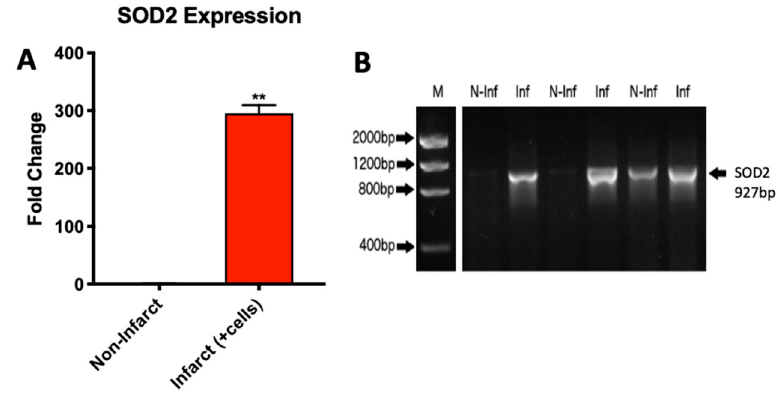
Figure 6. SOD2 transcripts are elevated in the infarcted zones of the sheep heart. The expression of this gene, downstream in the Hippo pathway, was significantly elevated in the infarcted repair region of the sheep heart indicating a shutdown of the inhibitory pathway ( A ). The size of the SOD2 transcript amplified by PCR was confirmed via gel imaging ( B ). n = 3, ** p < 0.01. Fold changes are shown as the mean ± SEM. All samples were run in triplicate.